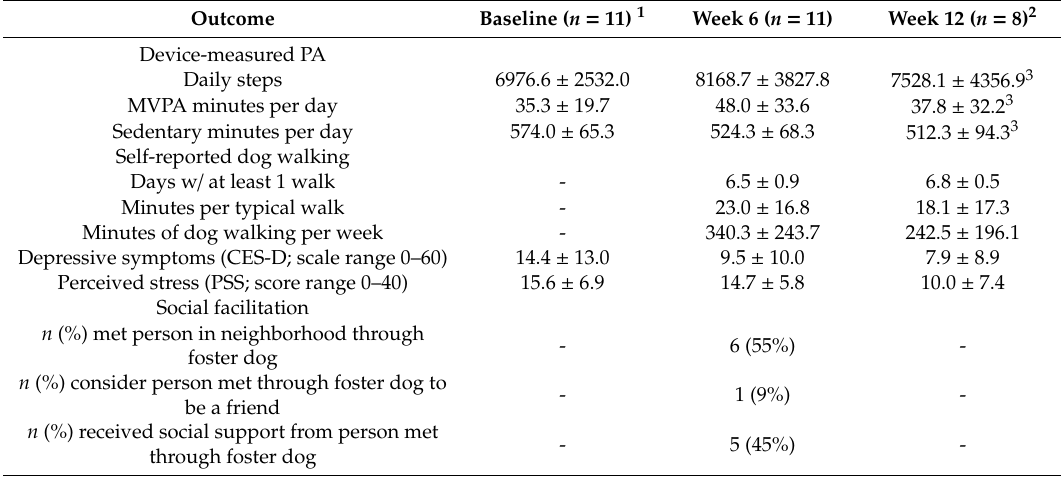
Table 1. BuddyStudy physical activity (PA) and psychosocial outcomes by time point.